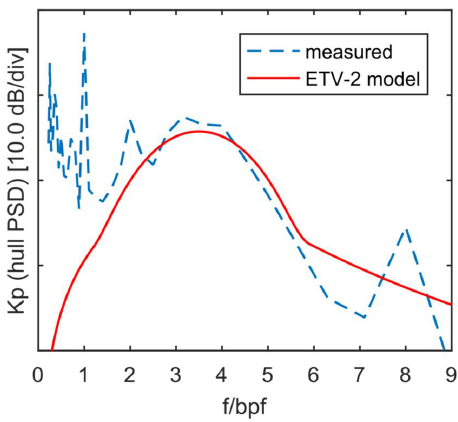
Figure 12. Example of the measured and predicted non-dimensional hull pressure spectrum for a ship propeller of the database tested at model scale.